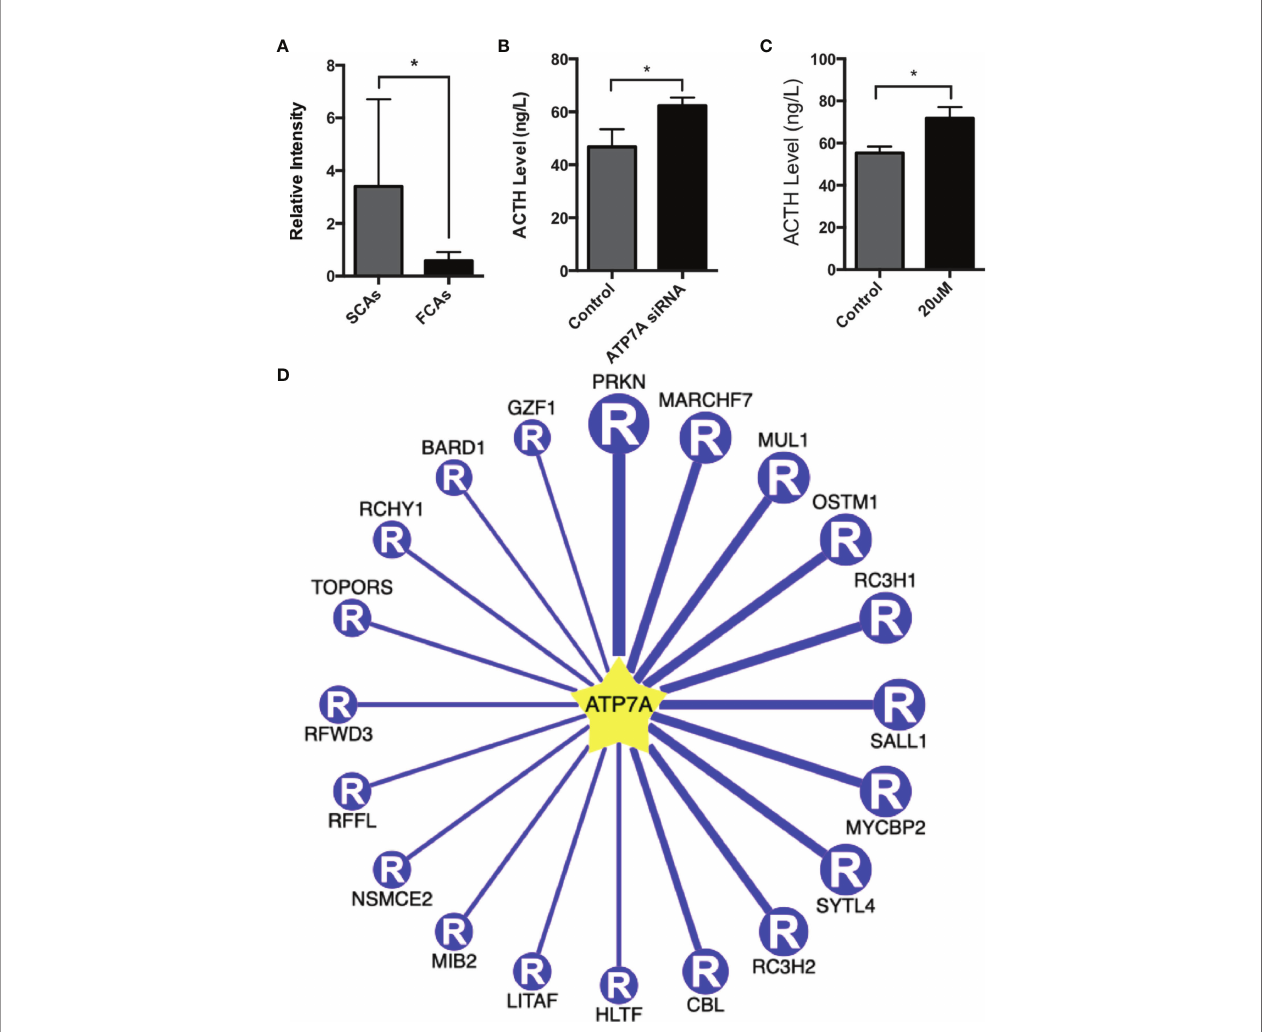
FIGURE 7 | Function of ATP7A in AtT20 cells. (A) The intensity of ubiquitinated peptides of ATP7A in SCAs and FCAs. (B) Up-regulation of the ACTH level in AtT20 cells with the knockdown of ATP7A by ATP7A siRNA. (C) Up-regulation of the ACTH level in AtT20 cells treated with 20uM omeprazole. All assays were performed in triplicate. (D) The top 20 potential E3 ligases of ATP7A. *Compared to control, p <